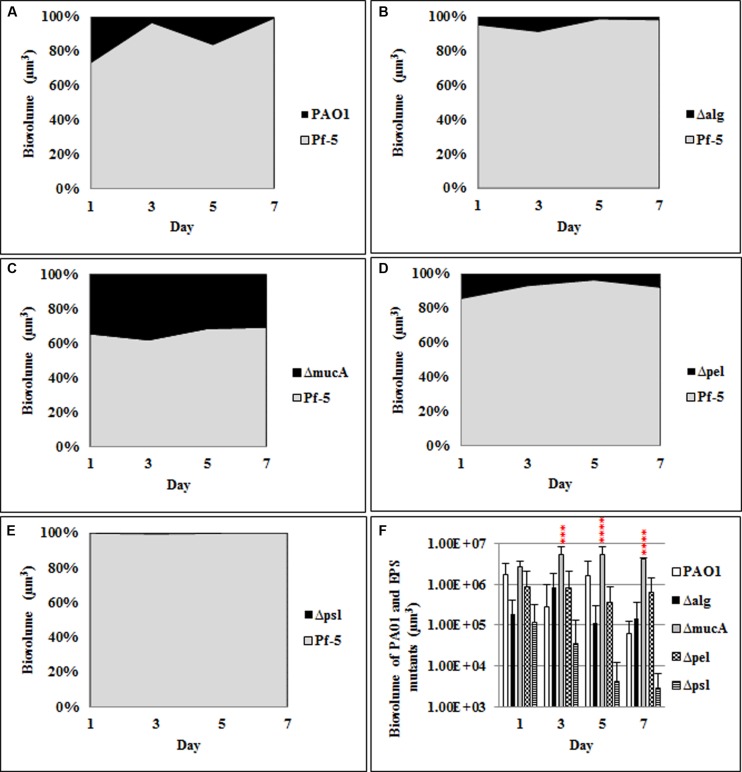
Spatial and temporal development of P. aeruginosa polysaccharide mutants grown with P. protegens as dual species biofilms. The proportion of the two species was calculated by quantitative image analysis. (A)
P. aeruginosa WT, (B) Δalg, (C) ΔmucA, (D) Δpel, (E) Δpsl, and (F) biovolumes of P. aeruginosa and polysaccharide mutants. Statistical analysis was performed vs. the corresponding WT samples grown in parallel, which were very similar in all cases ***P < 0.001, ****P < 0.0001.